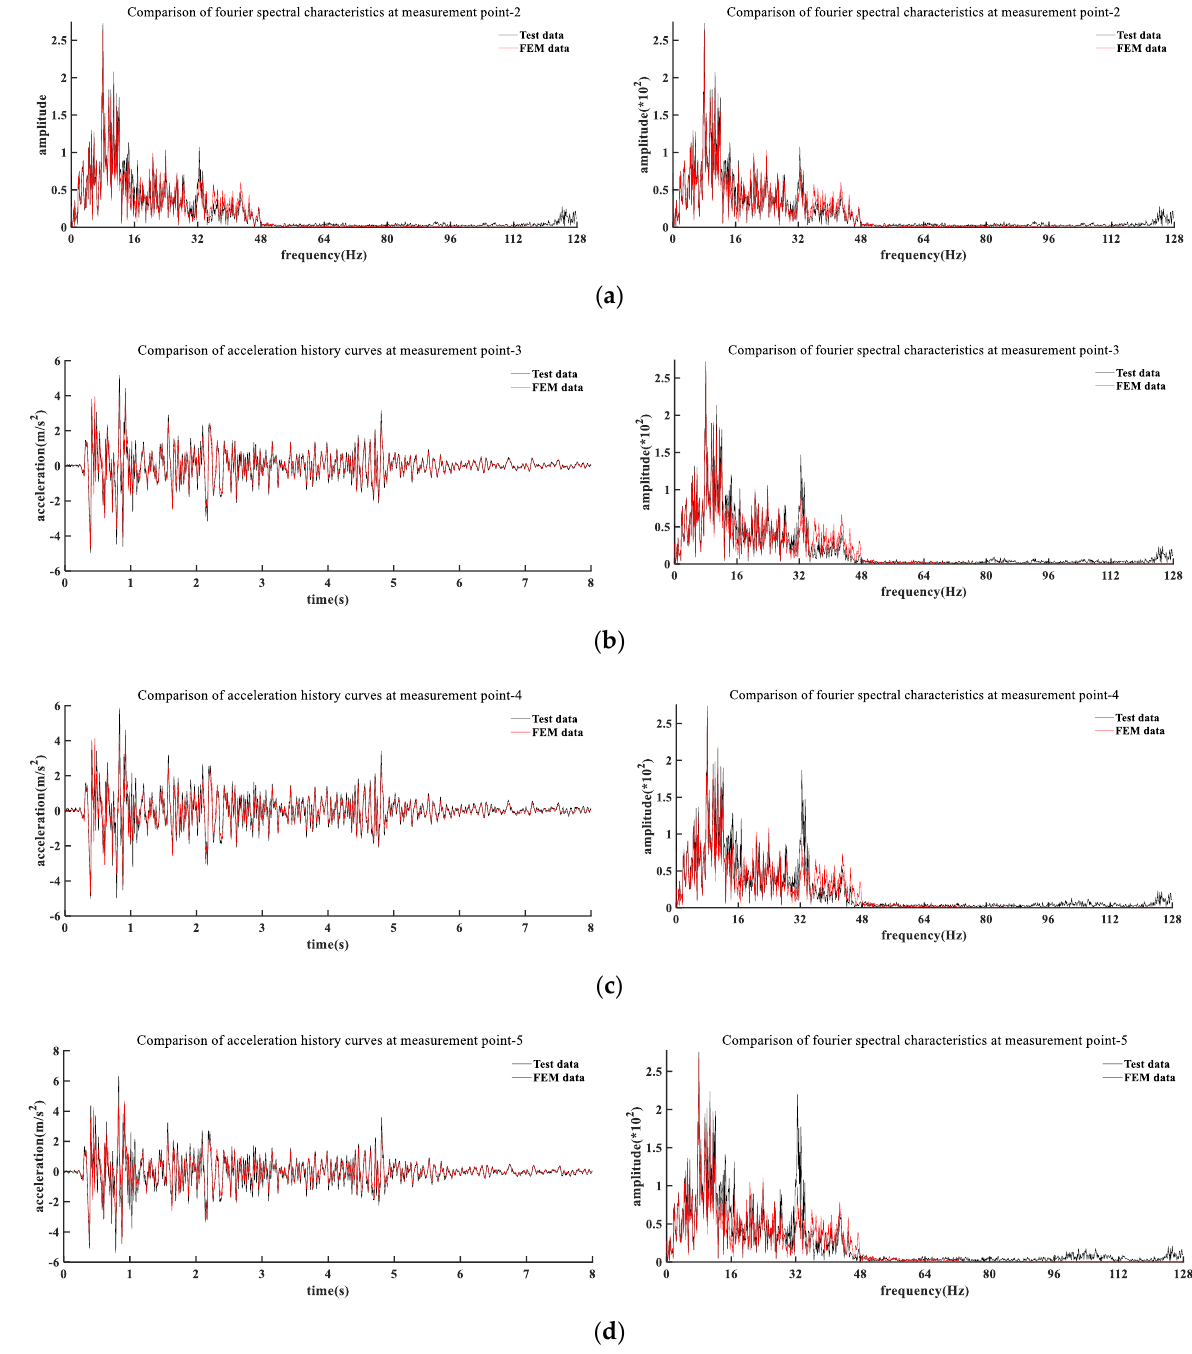
Figure 9. Comparison results of the seismic storage tank under El Centro (X, 0.5 g): ( a ) measuring point 2; ( b ) measuring point 3; ( c ) measuring point 4; ( d ) measuring point 5.